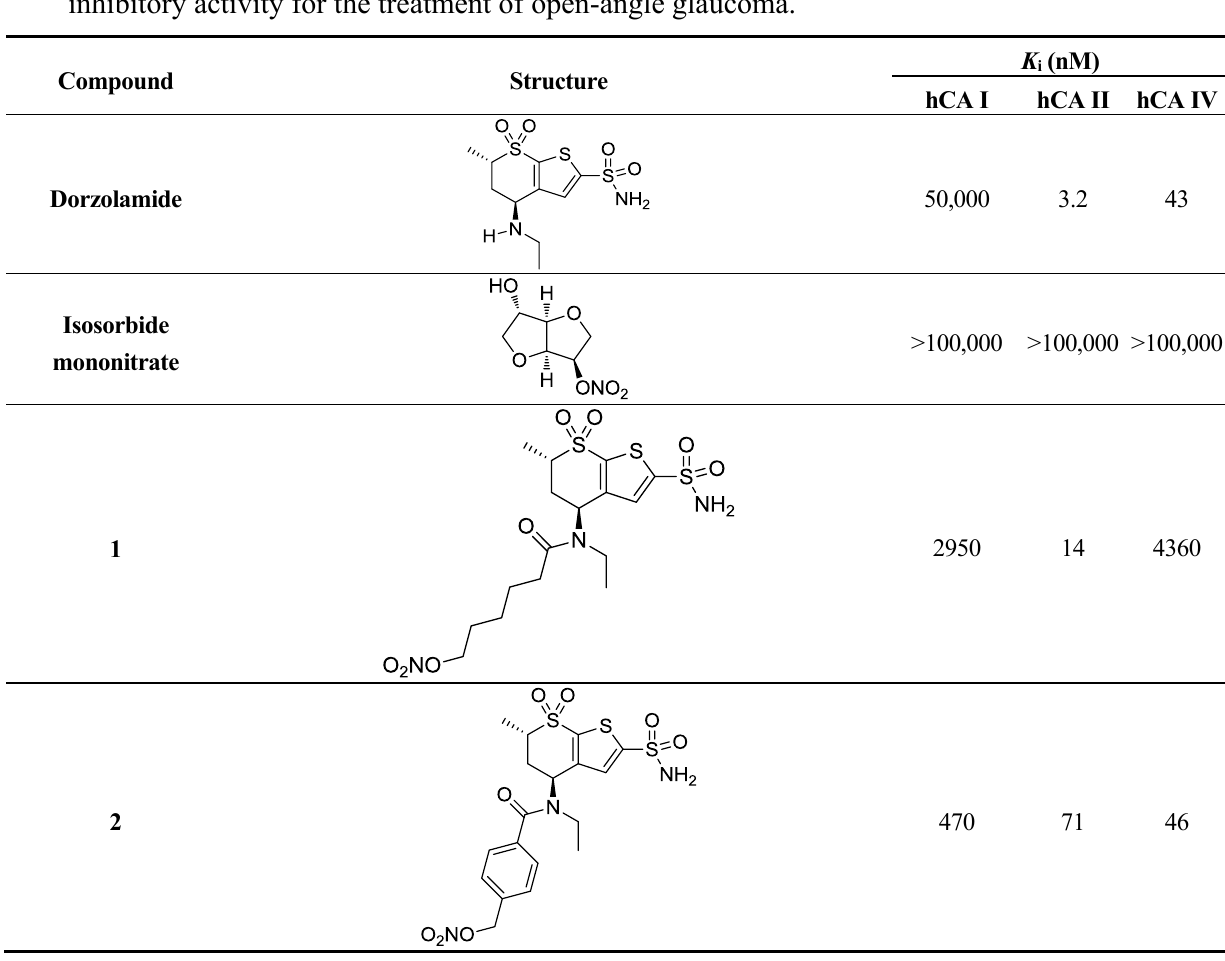
Table 1. Dual agents endowed with NO donating properties and selective hCA isoform inhibitory activity for the treatment of open-angle